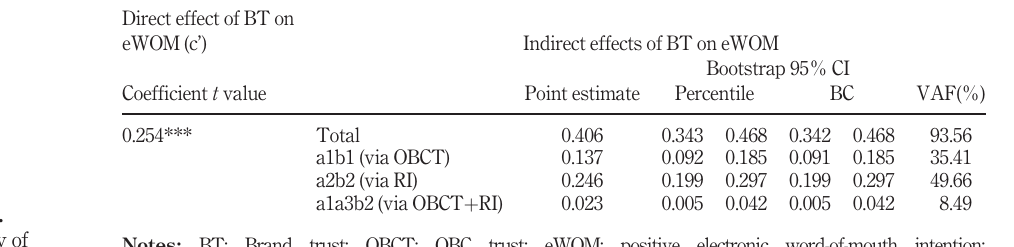
Table 4. Summary of mediating effect